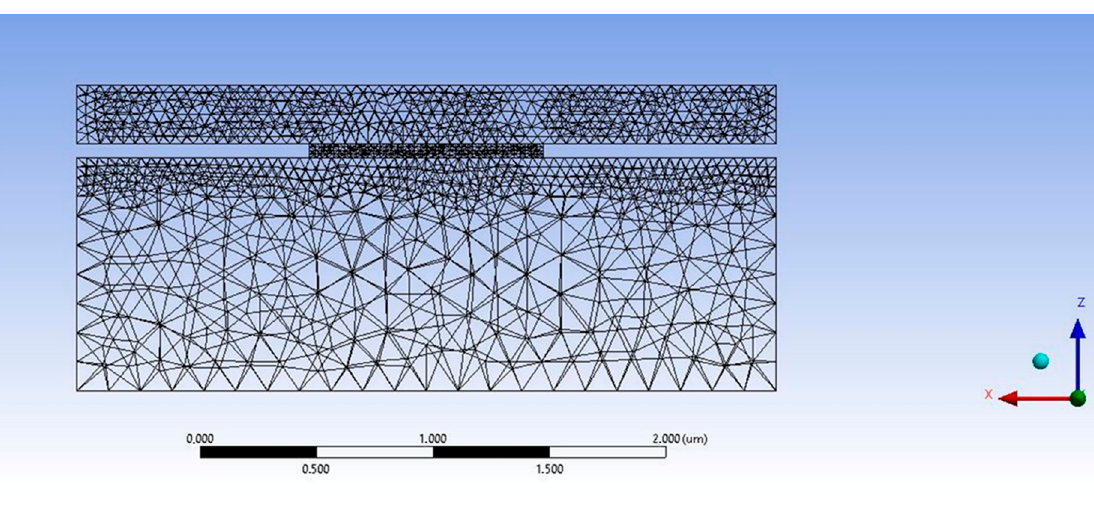
Figure 1. Meshing of the quartz/Ag NW/PEN (top/middle/bottom) interface according to the selected grid for two different nanowire geometries: cylindrical rods and cuboid parallelepipeds. Table 1. Mesh characteristics.